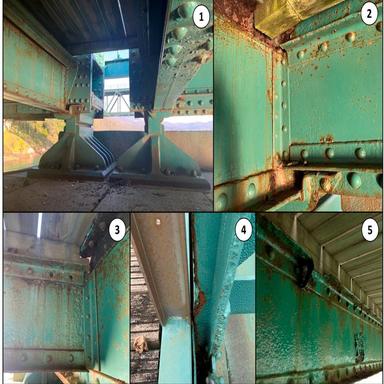
Details of the current condition state of the bridge: (1) simple support and the gap between spans (2) connection between stringers and crossbeams (3) lack of rivets in a stringer (4) heavily corroded retrofitted vertical hanger (5) corrosion in a crossbeam.